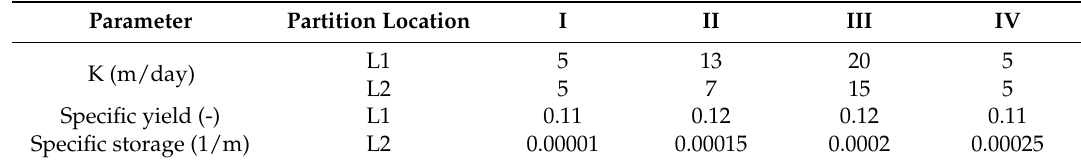
Table 2. Calibrated hydrogeological parameters in the regional groundwater model.